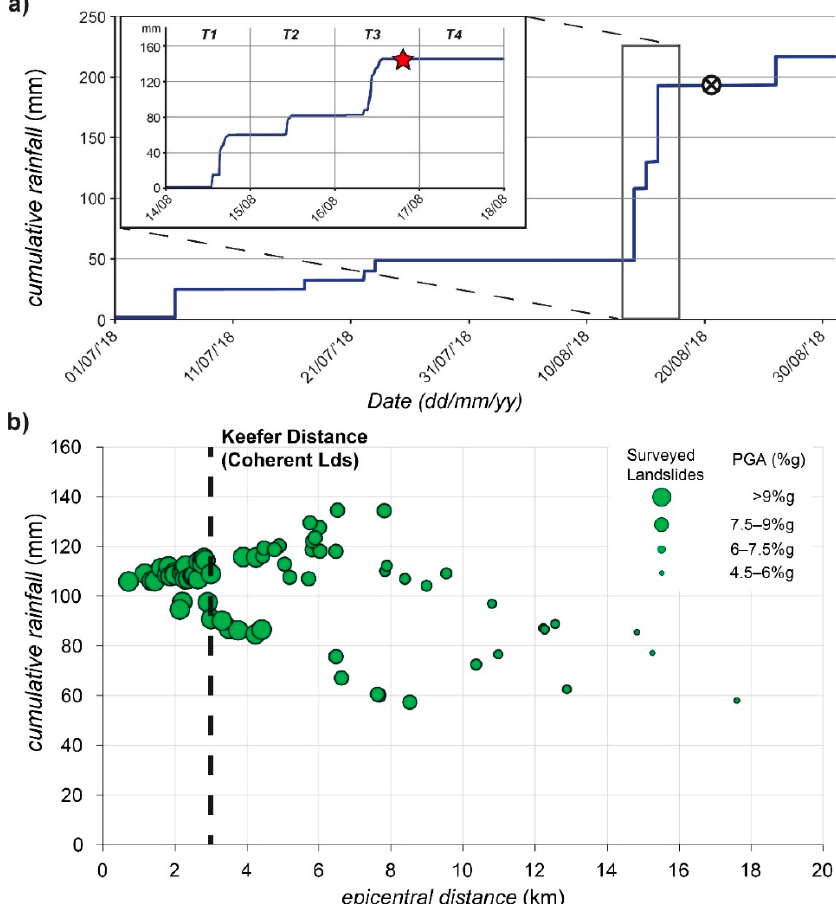
Figure 2. ( a ) Cumulative rainfall values recorded between 14 August 2018 and 17 August 2018 at Palata weather station. In the epicentral area, the rainfall event ended before the seismic shaking. The seismic event and the date of surveys are reported by the red star and black circle, respectively. ( b ) Coherent landslides distribution related to rainfall and peak ground acceleration. Keefer distance for coherent landslides is also reported (Modified from [20]).